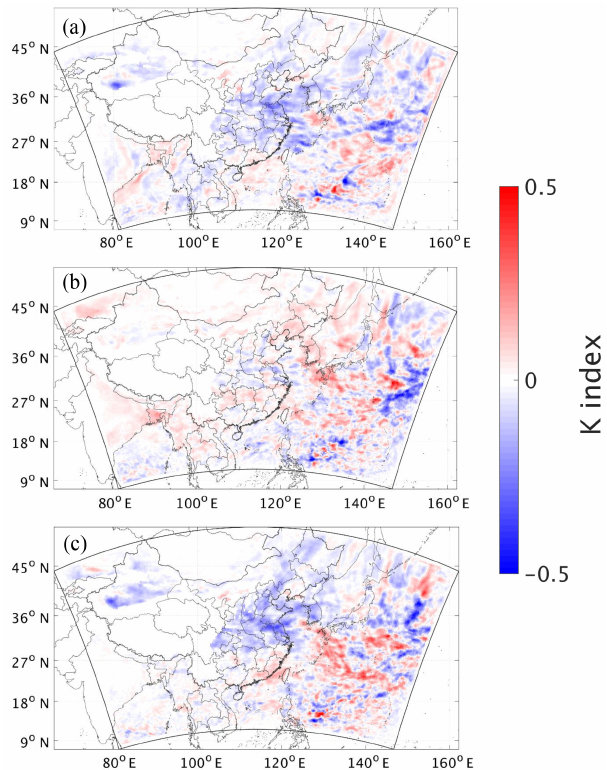
Figure 11. Spatial distributions of the modification of the K index induced by the direct radiative effect of dust (a) , the semi-direct and indirect effects of dust (b) , and the full effects of dust (c)